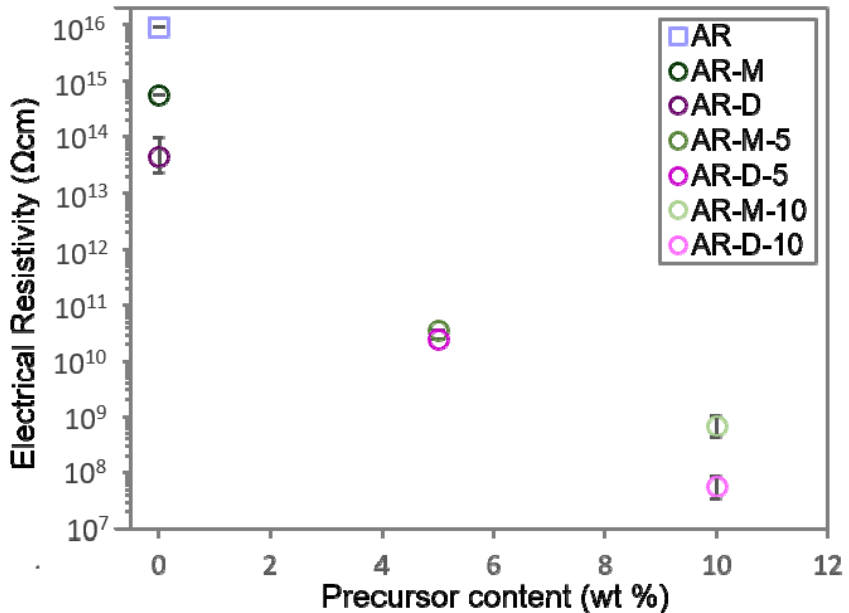
Figure 7. Electrical resistivity for the nanocomposites containing 0–10 wt% AgClO 4 and methanol/DMF solvents.